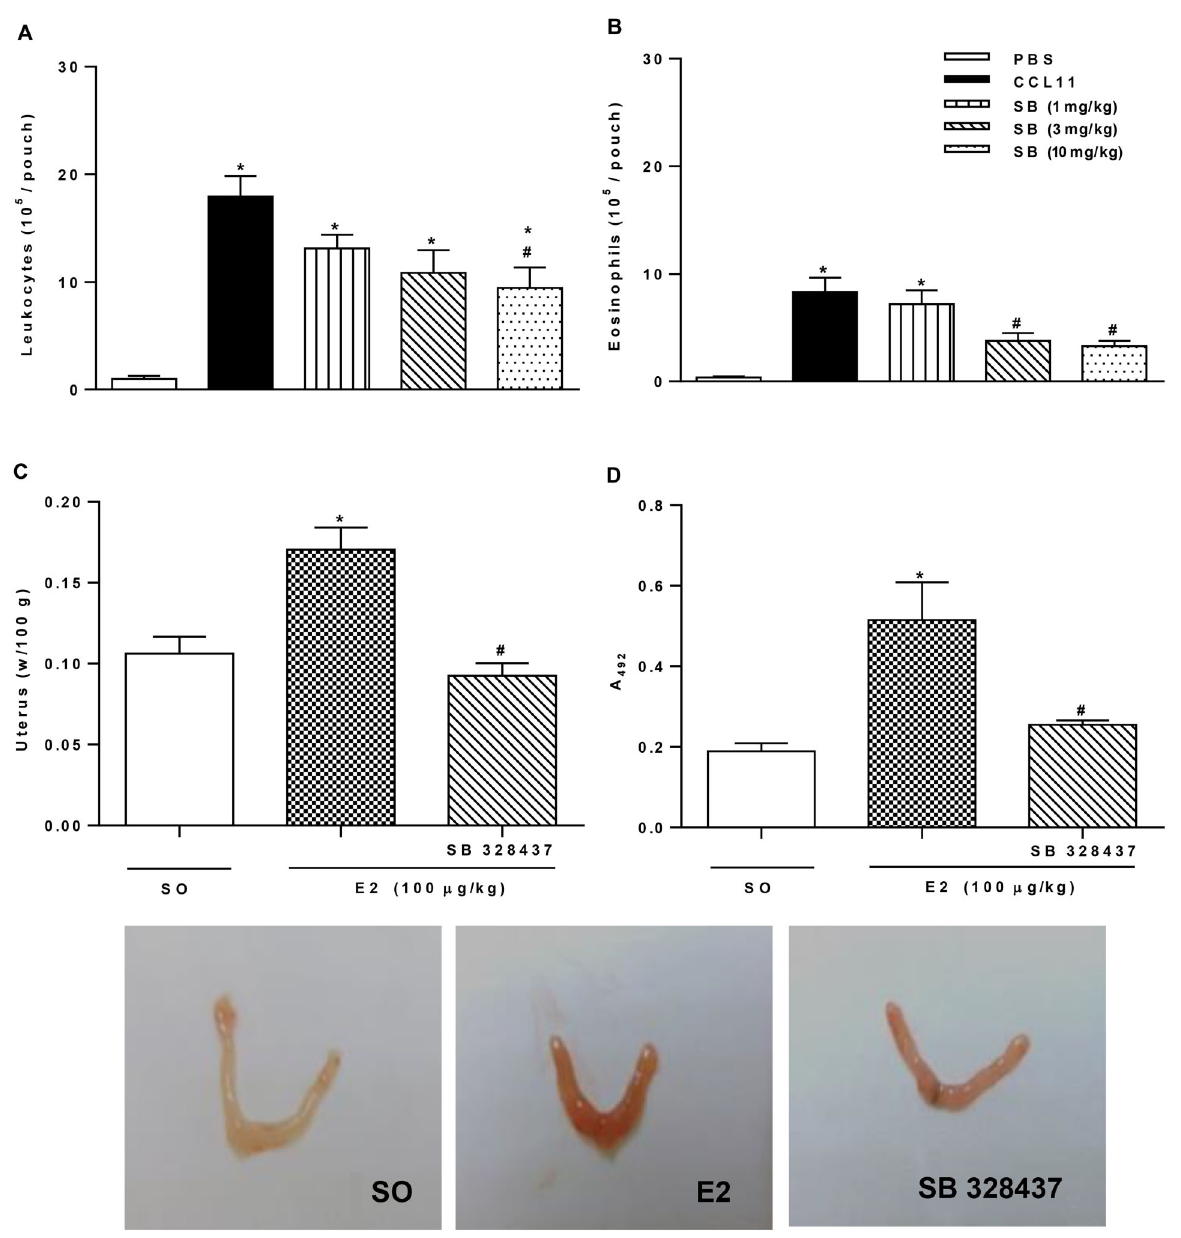
Figure 2. CCR3 antagonist dose that inhibited eosinophil migration. CCL11 (0.08 pmol/kg) was administered ( sc ) into the air pouch, and 4 h later approximately 1 mL of the exudate was collected for evaluation of ( A ) total leukocytes and ( B ) eosinophils. The antagonist dose (SB 328437; 3.0 mg/kg) was administered to the mice 30 min before 17- b -estradiol (E2) administration (100 m g/kg), and 24 h later the uterus was weighed for evaluation of ( C ) edema and ( D ) eosinophil peroxidase assay. Data are reported as means ± SE of 2 independent experiments. *P o 0.05 compared to PBS group (n=6) or SO group (n=5) and # P o 0.05 compared to CCL11 group (n=8) or E2 (n=5) (one-way ANOVA with Tukey post hoc correction). The photographs show the uterine atrophy/hypertrophy of ovariectomized mice treated with SO, E2, or with SB 328437 and